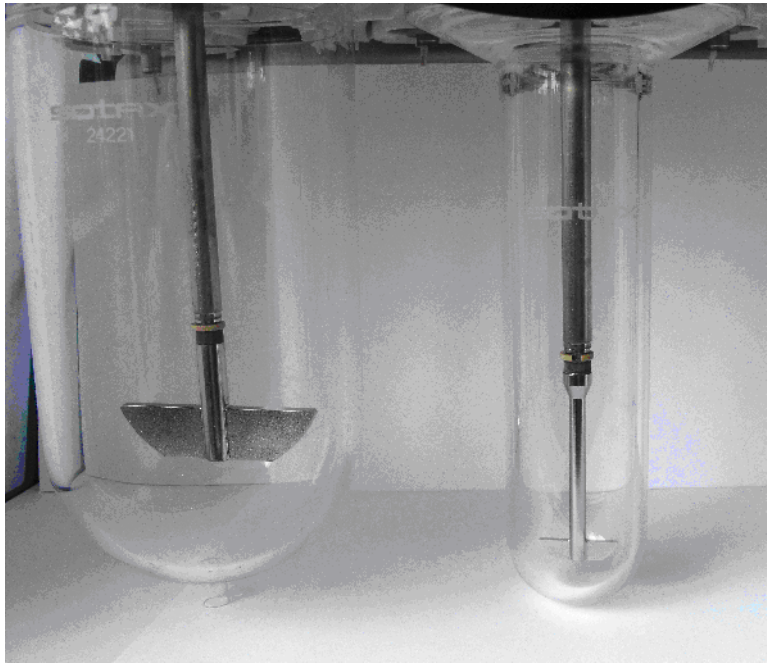
Figure 1. A small volume vessel equipped with small paddle (right side) and the compendial one liter vessel with paddle